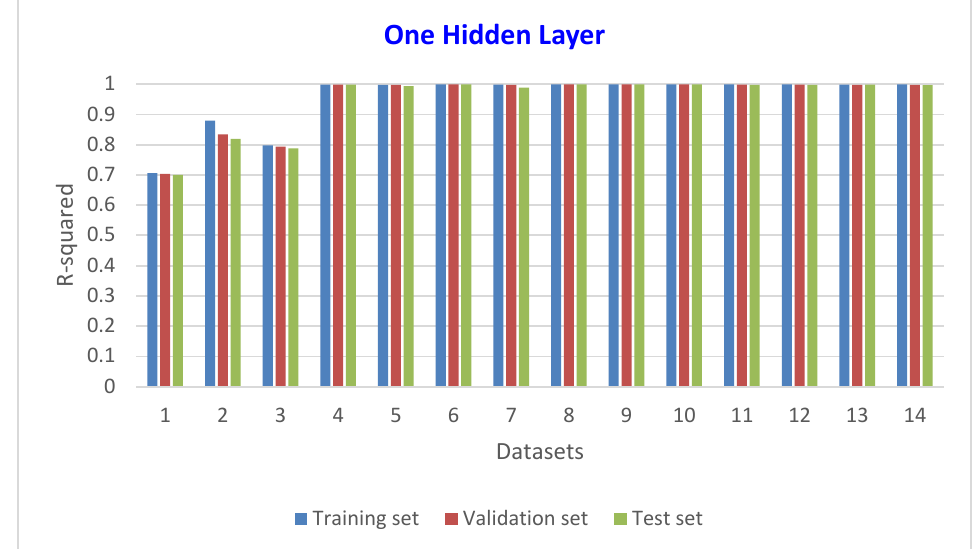
Figure 6. R-squared for the neural network model with one hidden layer. Table 7. Optimized parameters for the final model of the single hidden layer MLP model .